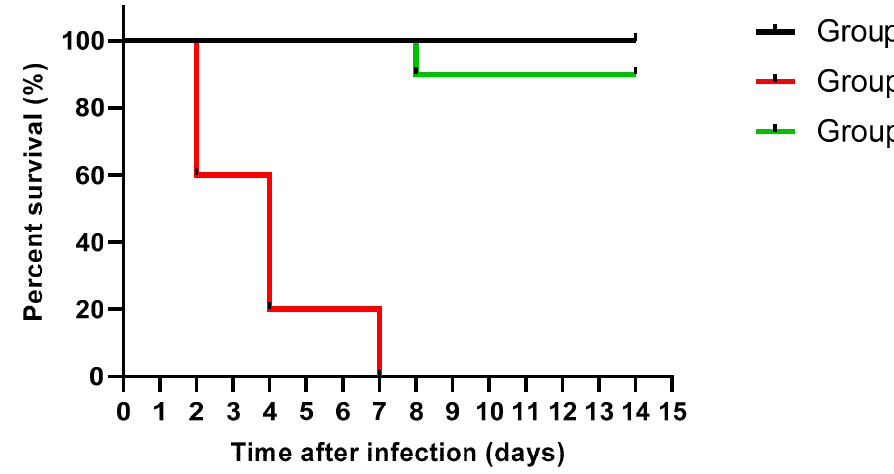
Figure 5. Kaplan–Meier survival curve of the experimental groups after treatment with catechin and gallic acid combination.